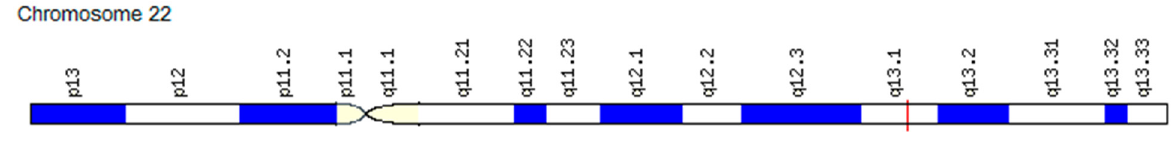
Figure 3. Localization of the PDGF-B gene on chromosome 22p13.1.